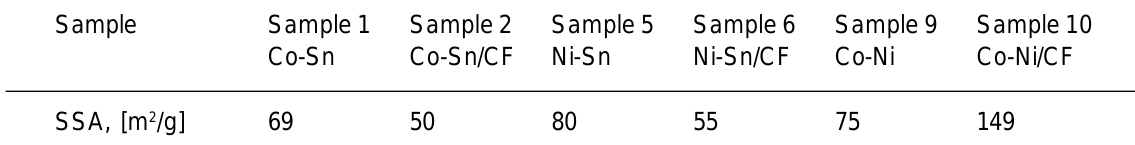
Table 4. Experimental data for the specific surface area, SSA [m 2 /g] measured by BET method.